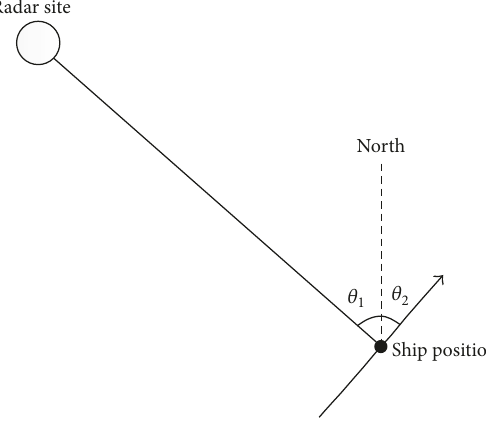
Figure 1: Bearing of ship to radar